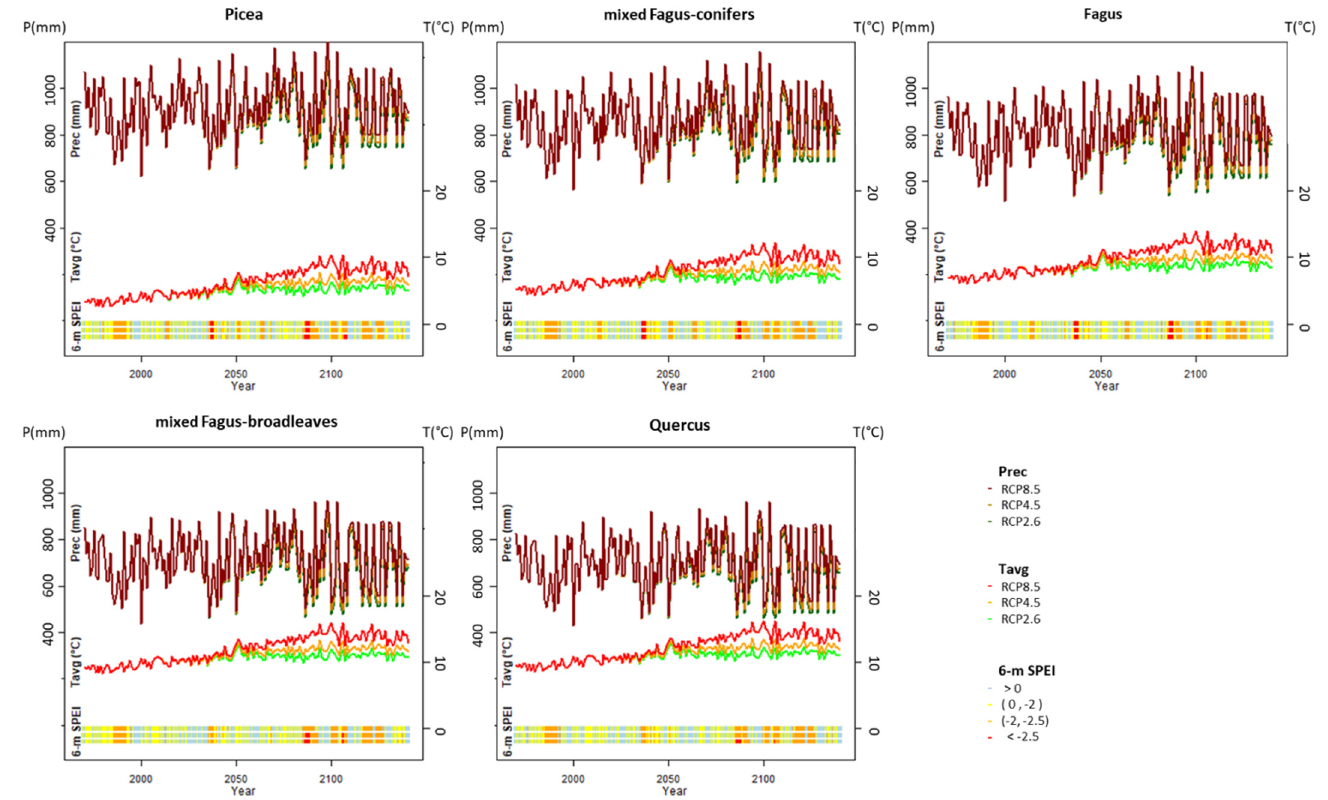
Figure 2. Comparison of climate change scenarios for the period 1970–2140 among the three RCP scenarios (RCP 2.6, RCP 4.5, RCP 8.5) in five main forest types representative of the altitudinal gradient (top to bottom). Precipitation (Prec), average temperature (Tavg) and standardized precipitation evapotranspiration index (SPEI index) (rows top to bottom represent RCP 2.6, RCP 4.5 and RCP 8.5, respectively).